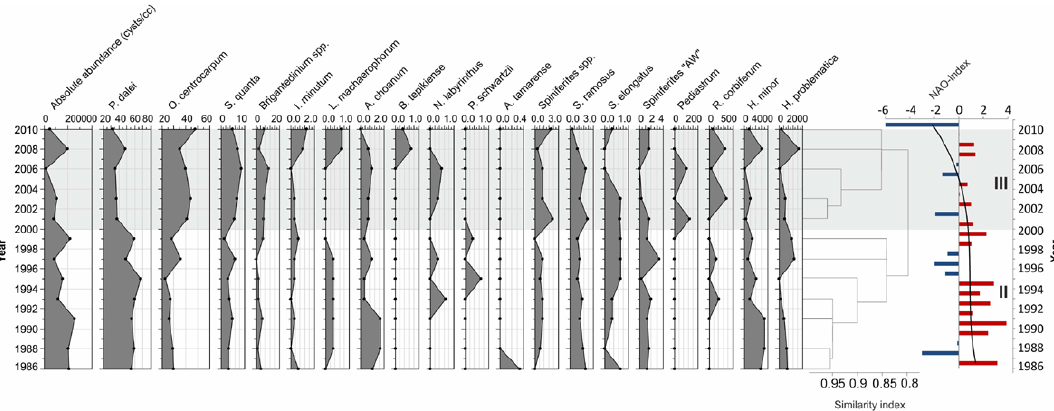
Fig. 5. Cyst assemblages in MC 61-1 and associated groups according to cluster analysis; cyst concentrations and Chlorophycean and Prasinophyceae algae are given in nbcc − 1 , relative dinocyst abundances are given in %; the NAO index is shown to the right (Hurrell, 1995).